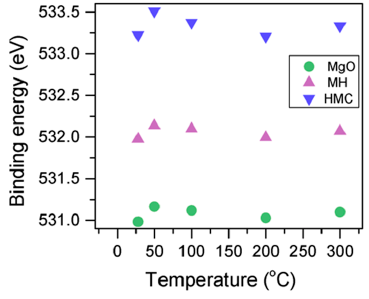
Figure 2. Evolution of the O1s peak position as the temperature increases.